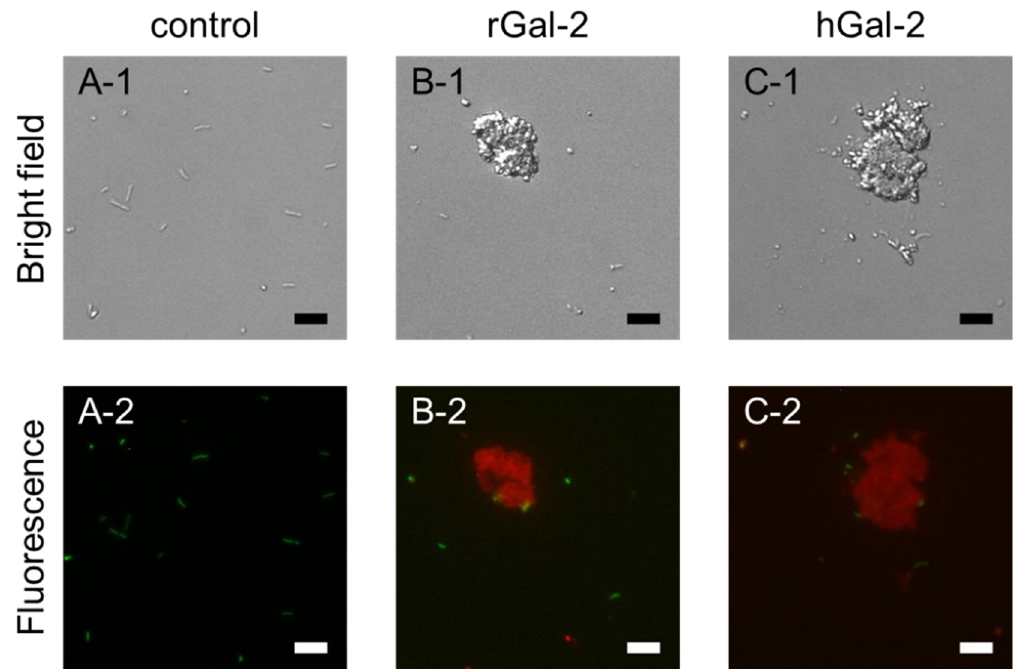
Figure 5. Bactericidal effect of Gal-2 against H. pylori . ( A ) Control (without Gal-2). ( B ) rGal-2. ( C ) hGal-2. Upper (1) and lower (2) images are transmission and fluorescence images, respectively. Live and dead H. pylori cells were stained with carboxyfluorescein diacetate (CFDA; green) and propidium iodide (PI; red), respectively, for 10 min. The concentration of Gal-2 was 93.9 µg/mL. Scale bars represent 10 µm.